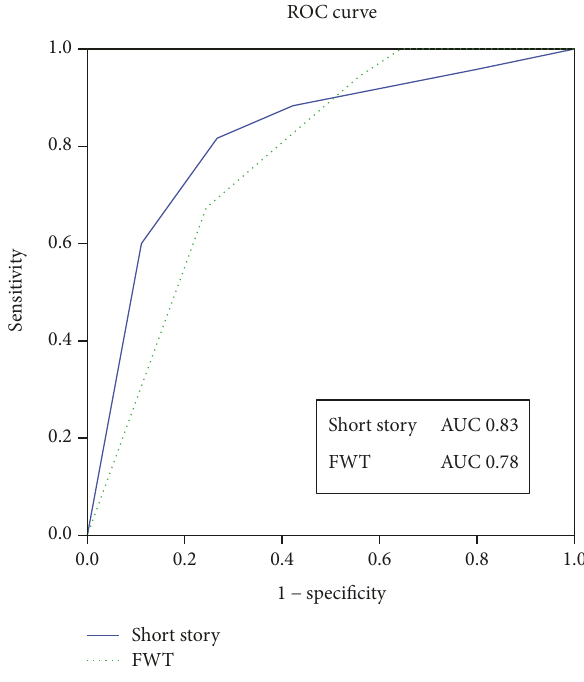
Figure 1: Receiving operating characteristic (ROC) curves of the short story equivalent score and the fi ve-word test (FWT) total score: discrimination of mild cognitive impairment due to Alzheimer ’ s disease from healthy subjects. AUC indicates the area under the curve.